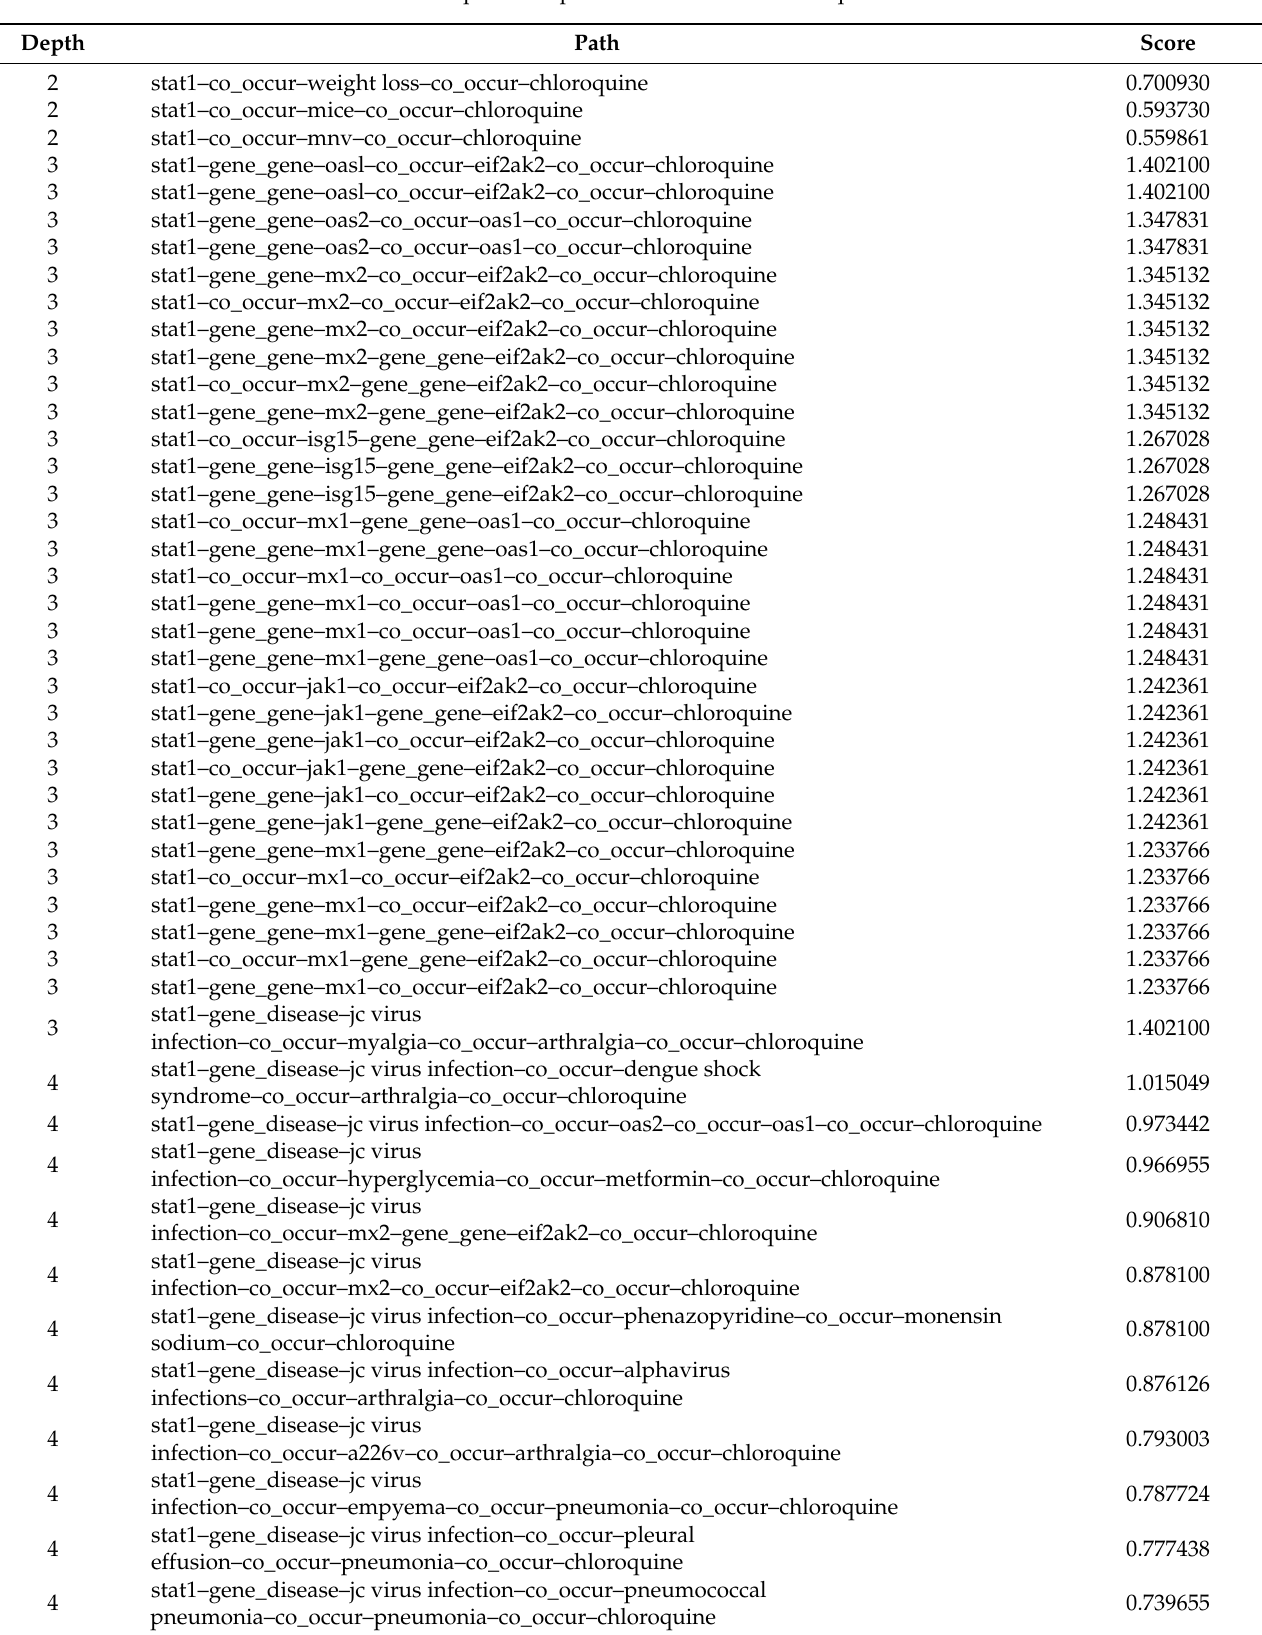
Table 8. Top-ranked paths from STAT1 to